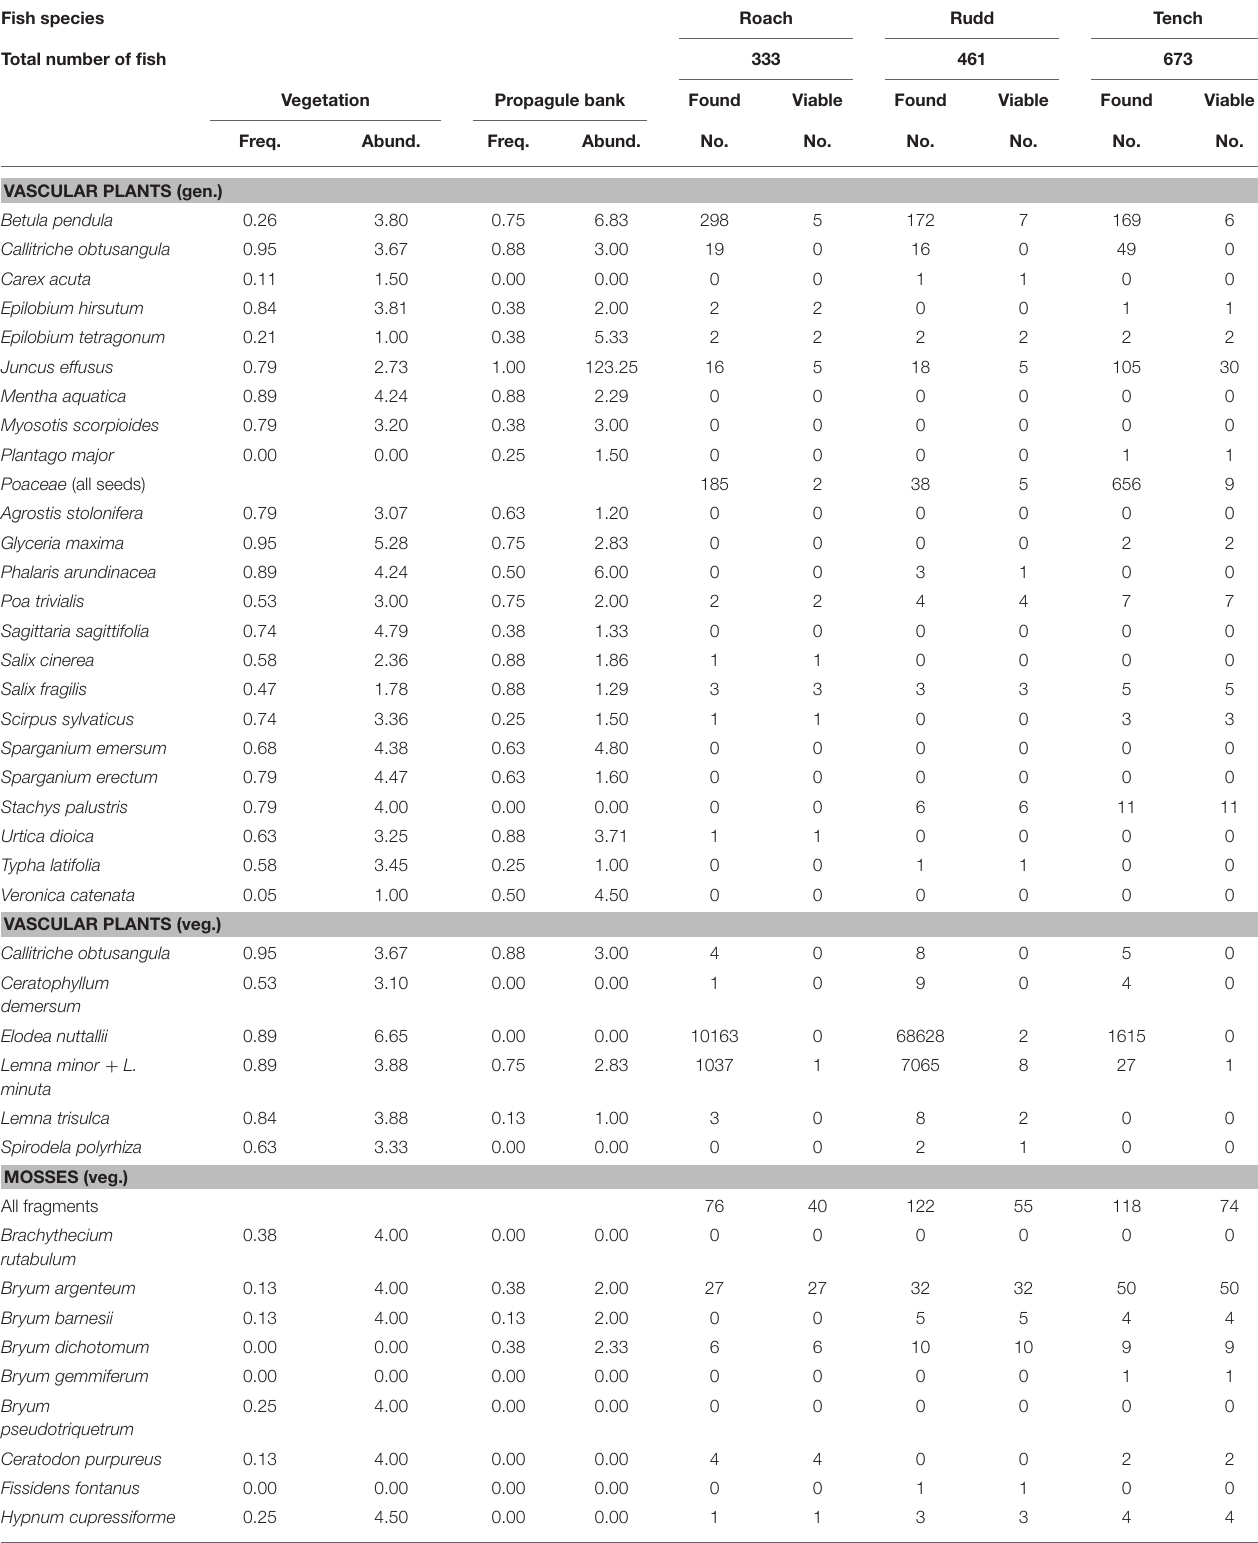
TABLE 1 | Frequency and abundance of plant species in the vegetation and propagule bank, the number of generative (gen.) and vegetative (veg.) propagules found in the feces and the number of propagules found that proved to be viable (germinated or regenerated) for each of the three fish species. Fish species Roach Rudd Tench Total number of fish 333 461 Vegetation Propagule bank Found Viable Found Viable Found Viable Freq. Abund. Freq.